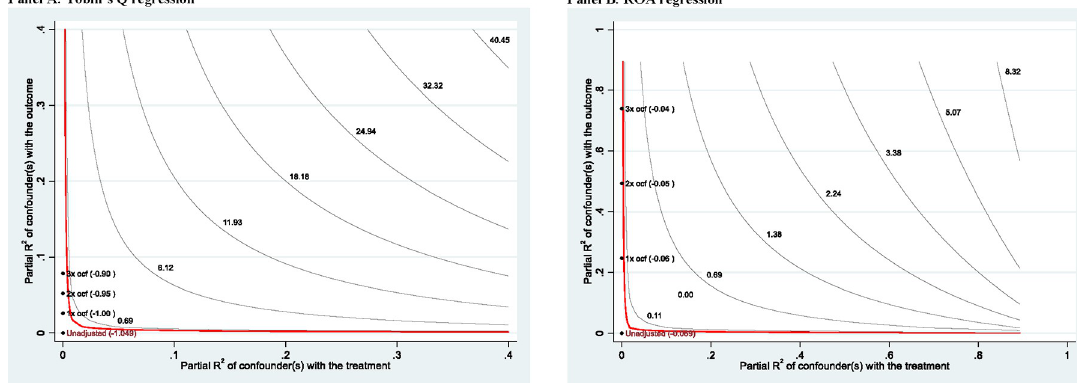
Fig 3. Sensitivity of OLS estimates to omitted variables. This figure shows how sensitive the OLS estimates are to omitted variables using the approach of Cinelli and Hazlett (2020). The figure plots the adjusted point estimates of the efficient of Floodratio (our main variable of interest), when including an unobservable variable in the regression. The horizontal axis describes the fraction of the residual variation in Floodratio explained by the confounder, and the vertical axis describes the fraction of the residual variation in Tobin’s Q or ROA explained by the confounder (Panel A for the Tobin’s Q regression and Panel B for the ROA regression). We use OCF (i.e., Operating cash flows / Total assets) as the benchmark variable. OCF is highly signficantly and positively correlated with both Tobin’s Q and ROA at the 1% level (the correlation coefficient is 0.189 between OCF and Tobin’s Q and 0.527 between OCF and ROA ). In Panel A (for the Tobin’Q regression) and Panel B (for the ROA regression), the three points on each plot show the bounds on the partial R 2 of the unobserved confounder if it were k (k = 1, 2 or 3) times “as strong” as the benchmark variable OCF . Both plots show that the signs of the point estimates of the efficient of Floodratio are still negative and relatively insensitive to a confounder with various strengths of the benchmark